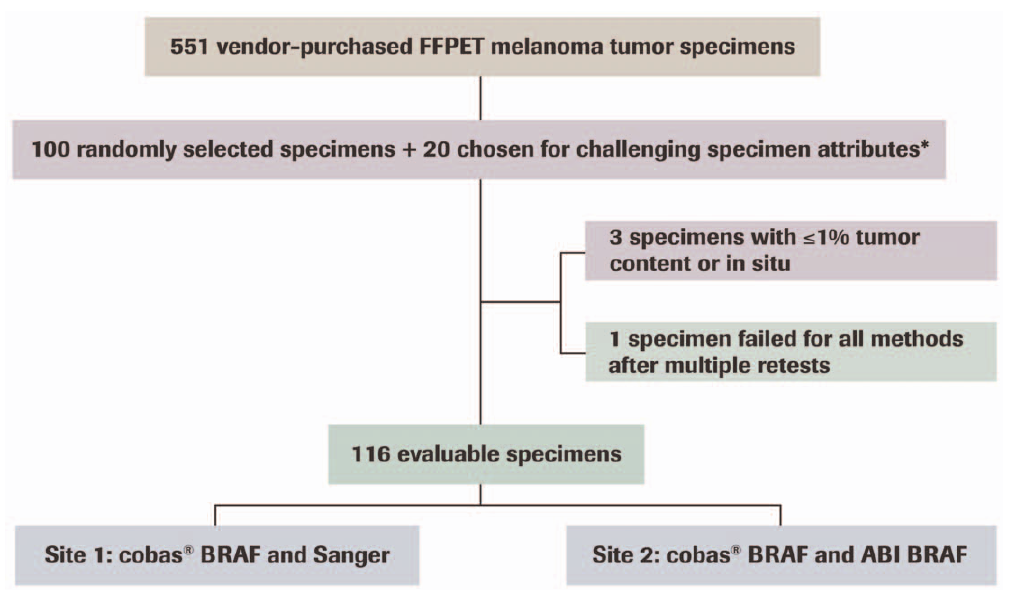
Figure 2. Study design and specimen selection. FFPET=formalin-fixed paraffin-embedded tissue. * Low tumor content ( , 50%); high levels of necrosis ( $ 50%); significant pigmentation ( , 10%); or non-V600E mutations.